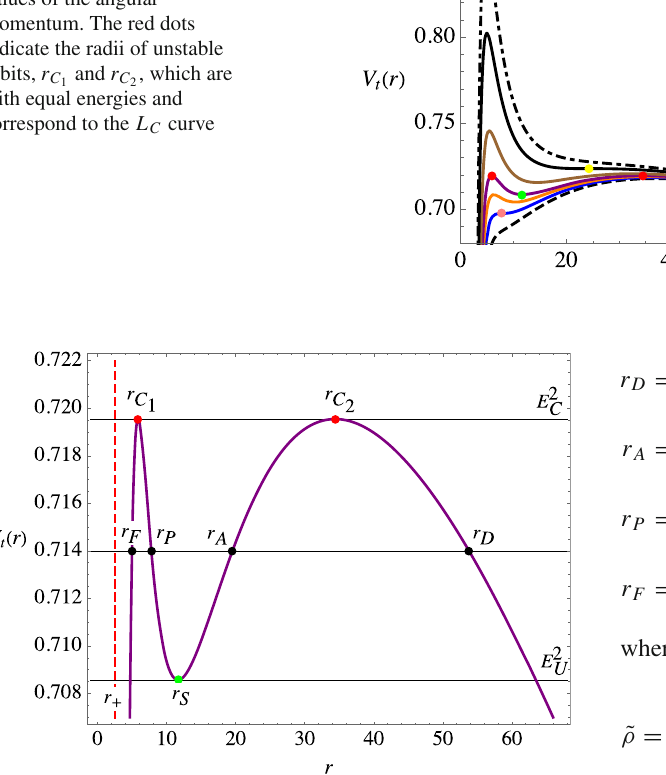
Fig. 9 The different curves of V t ( r ) plotted for γ = 0 . 001, and ramified in terms of the limiting values of the angular momentum. The red dots indicate the radii of unstable orbits, r C and r C , which are 1 2 with equal energies and correspond to the L C curve